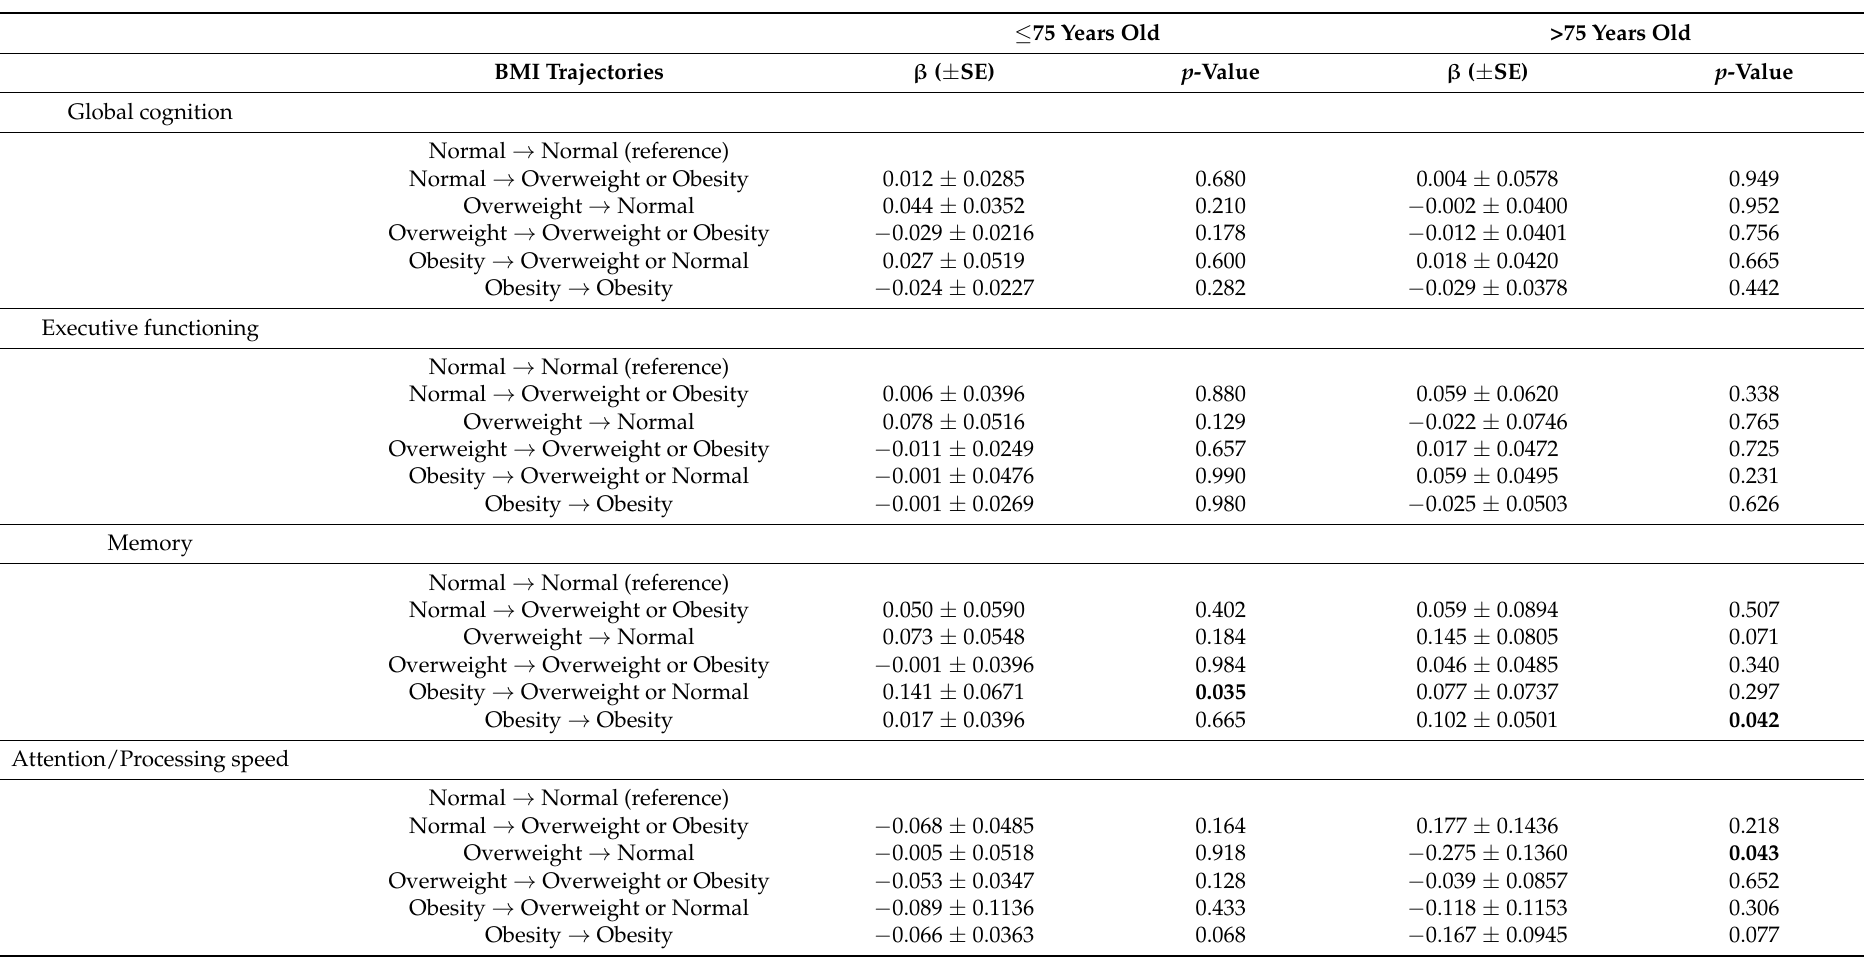
Table 2. Results from generalized estimating equations that evaluated the association between BMI trajectories (independent variables) and differential rates of change of cognitive composite scores over time (dependent variables) in participants without dementia at